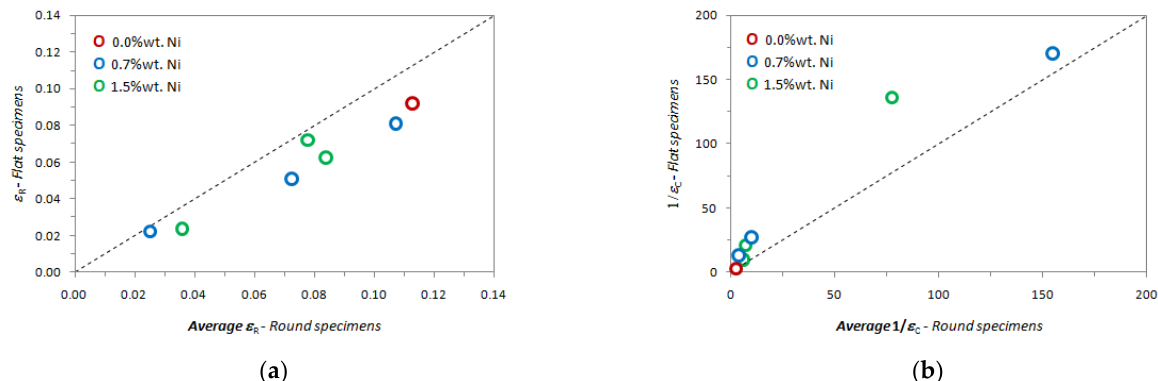
Figure 22. ( a ) Strains to rupture ( ε R ) comparison from round and flat tensile specimens from 25 mm Y-block ADIs for different Ni contents and austempering conditions: ε R —flat tensile specimens vs.